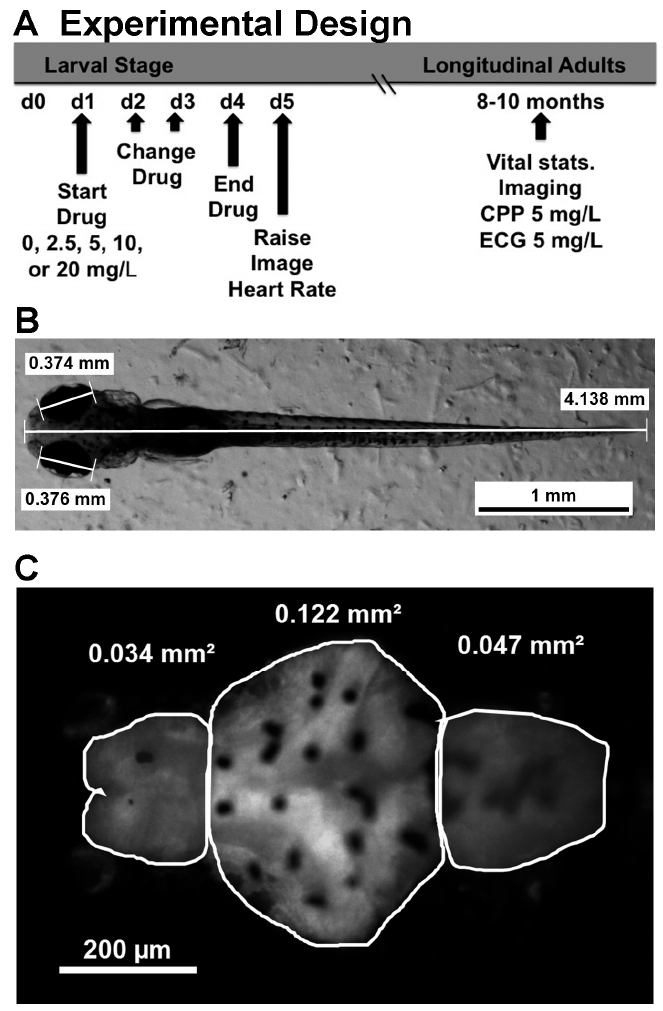
Figure 1. Experimental design of cocaine treatment and analysis of five-day larval zebrafish. A schematic showing the time course of embryonic drug exposure, imaging and longitudinal analysis is shown in ( A ); ( B ) shows an example of body length and eye diameter measurements made under bright field illumination; ( C ) shows the same fish under fluorescence illumination, focusing specifically on the brain at higher magnification. The tracing outlines the telencephalon (Tel), the diencephalon (Dien, which actually includes the optic tectum, midbrain and cerebellum), and the hindbrain (Hind, which includes the rhombencephalon), with sample area measurements given for each region.